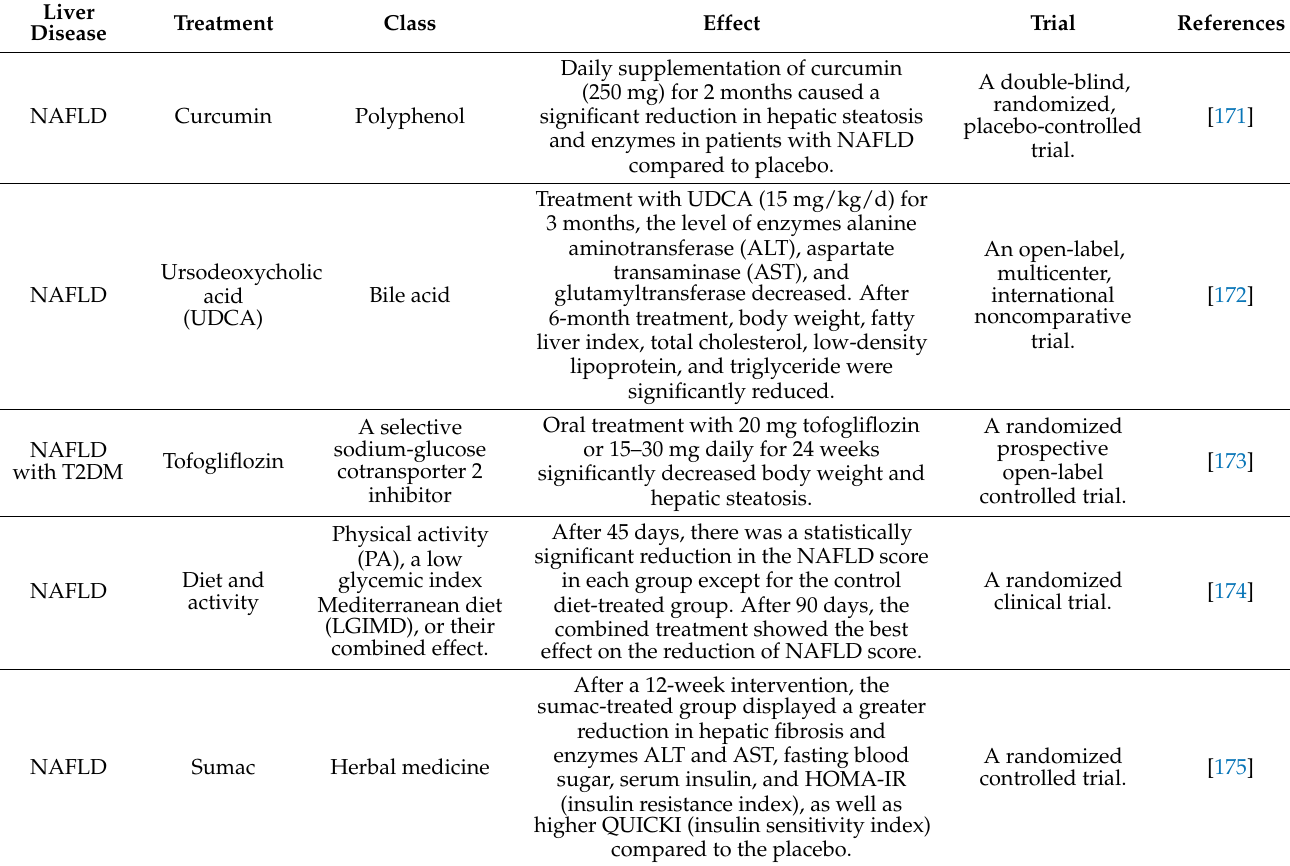
Table 3. The completed clinical trials for NAFLD/NASH